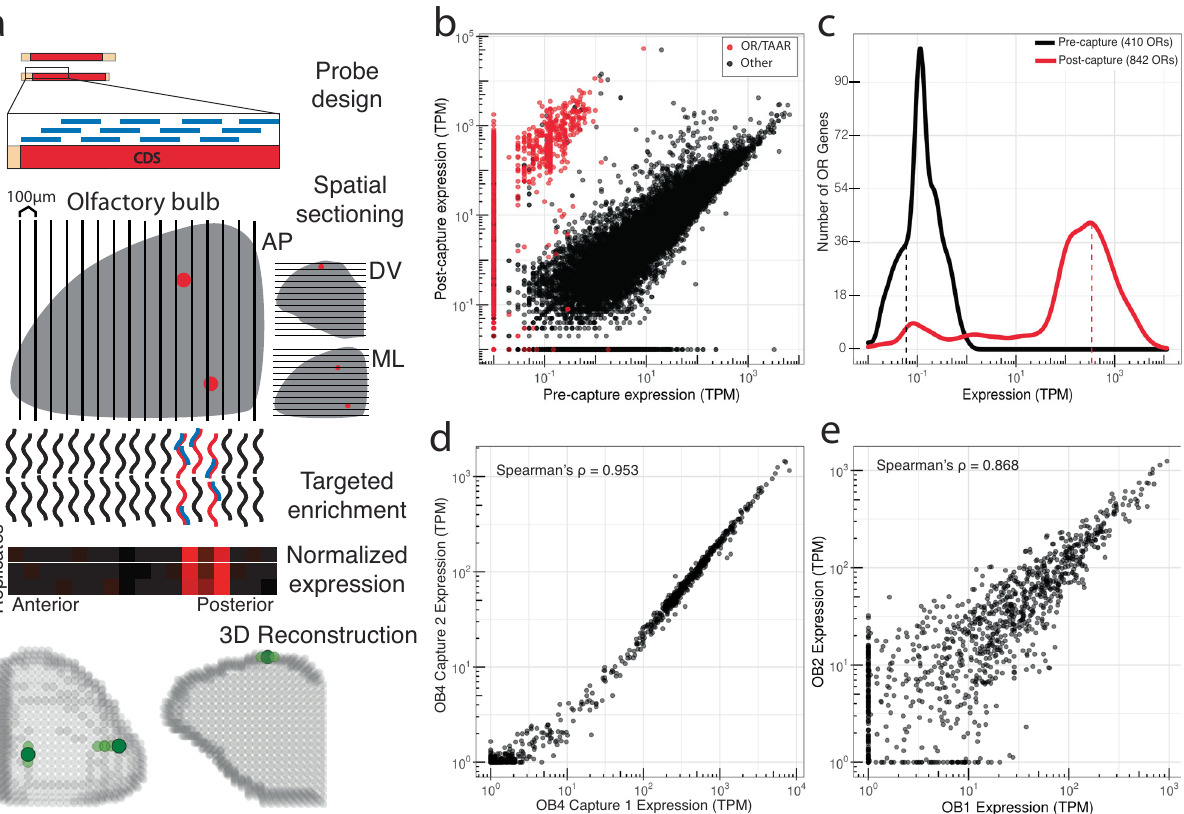
Fig. 1 | Target capture sequencing consistently enriches OR transcripts. a MethodologicaloverviewfortargetedenrichmentofORandTAARtranscripts from OB sections. Brie fl y, RNA is extracted from OB tissue and used for cDNA synthesis and library preparation. Biotinylated capture probes are designed against coding sequences (CDS) of interest, enabling enrichment of target genes following streptavidin binding and washing steps. RNA-Seq of enriched libraries allows for high-throughput positional analyses when combined with systematic tissue sectioning in both individual dimensions and in 3D after